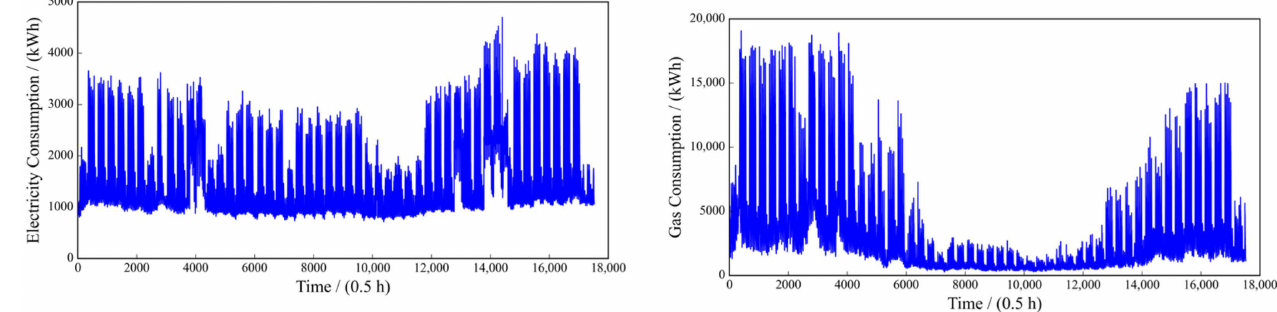
Figure 5. Half-hour resolution energy consumption curves for UK office buildings in 2018.